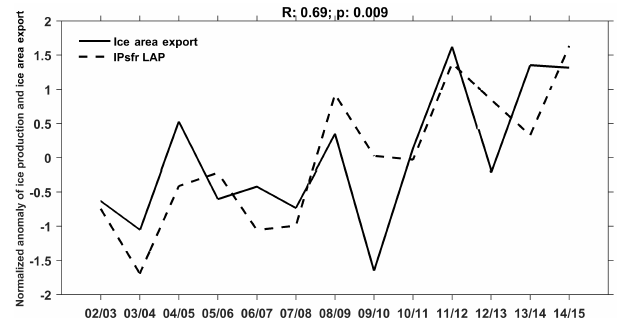
Figure 12. Normalized anomalies of accumulated winter ice pro- duction (IP of the present study, dashed line) and accumulated ice area export (IAE, solid line) for the winter seasons from 2002/2003 to 2014/2015. IAE data are based on an updated time series from Krumpen et al.